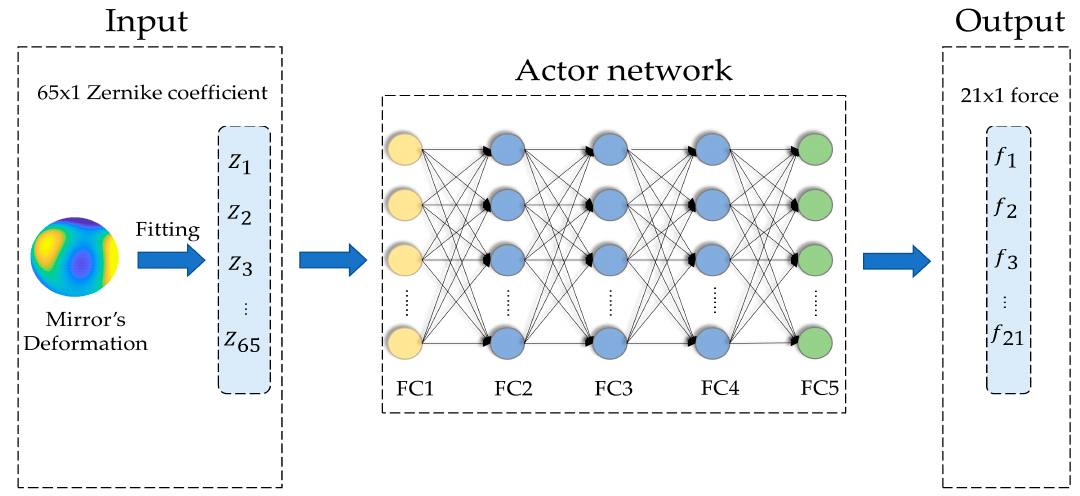
Figure 3. The process of the actor network.